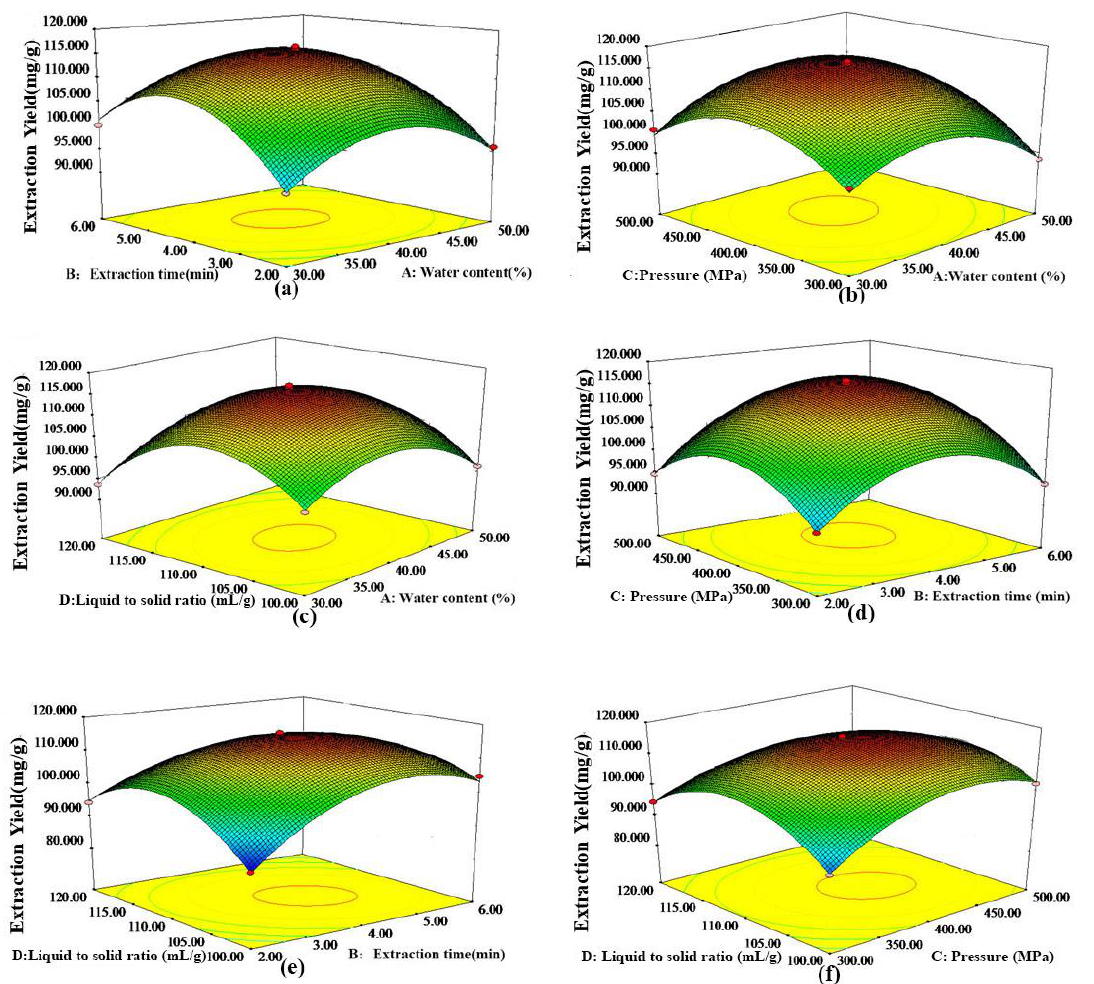
Figure 2. 3D response surface plots of baicalin. ( a ) Varying extraction time and water content; ( b ) Varying extraction pressure and water content; ( c ) Varying liquid-solid ratio and water content; ( d ) Varying extraction pressure and time; ( e ) Varying liquid-solid ratio and extraction time; ( f ) Varying liquid-solid ratio and extraction pressure.